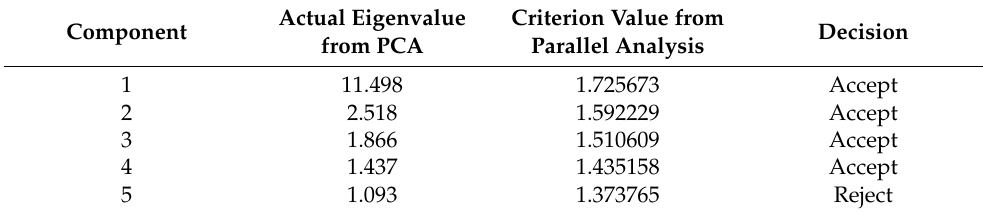
Table 2. Comparison of eigenvalues from PCA and Horn’s parallel analysis.